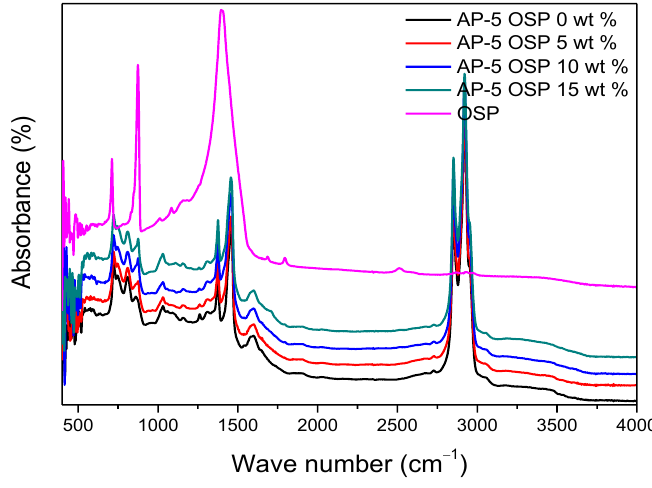
Figure 4. FT-IR spectra of OSP, neat asphalt, and OSP-filled asphalts.